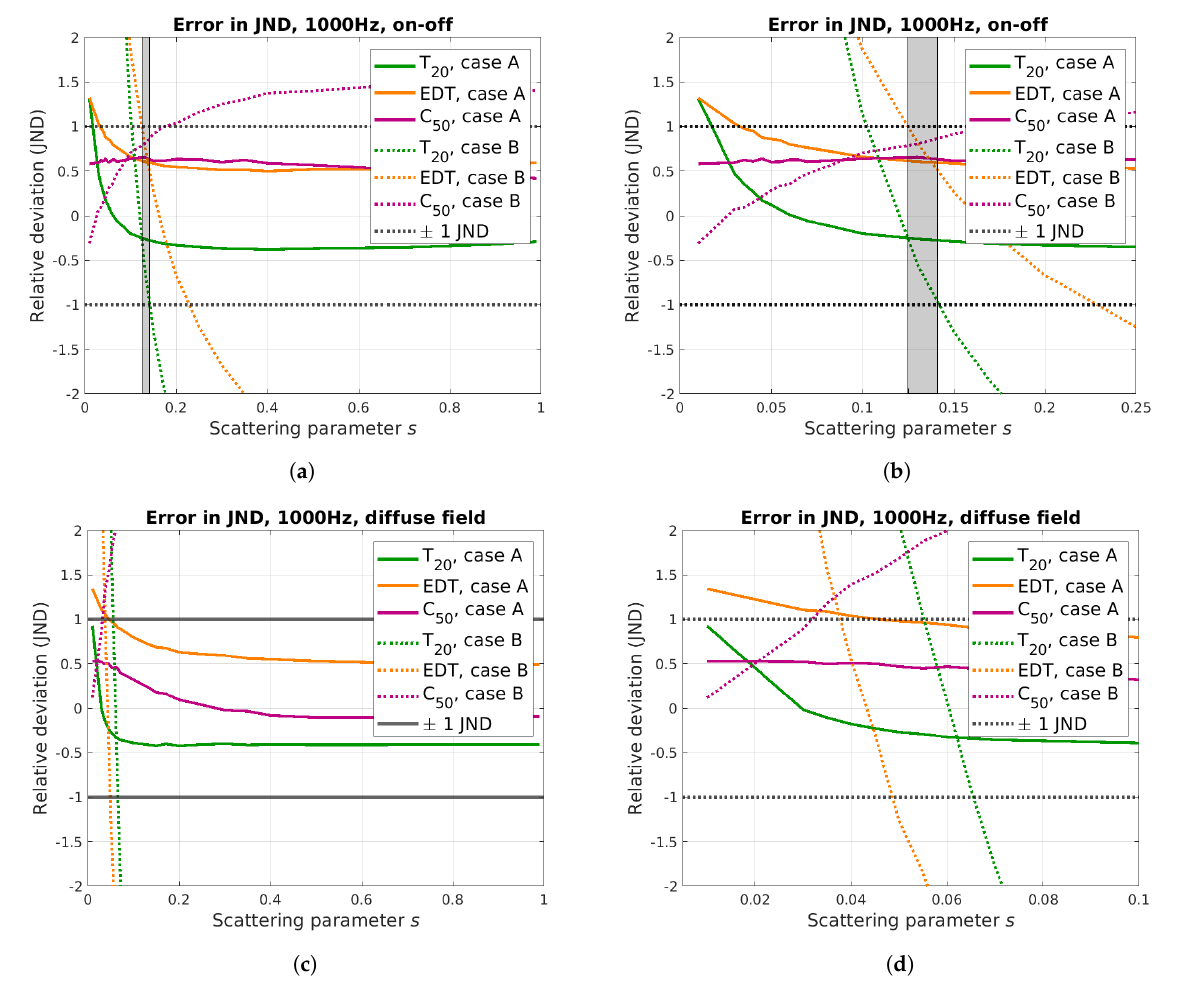
Figure 4. Graphs illustrating the procedure of tuning the scattering parameter. The graphs show the deviation between the simulated room acoustic parameters and the measurements at 1000 Hz, normalized to the respective JND, as shown in Equation (3). For the simulations to be sufficiently close to the measurements, all room acoustic parameters should be within 1 JND of the measurements. This occurs within the grey area in Figures ( a , b ) showing results for the on–off algorithm, but does not occur simultaneously for all parameters in Figures ( c , d ), showing results for the diffuse field algorithm. Note the differences in scale along the x-axis between Figures ( b , d